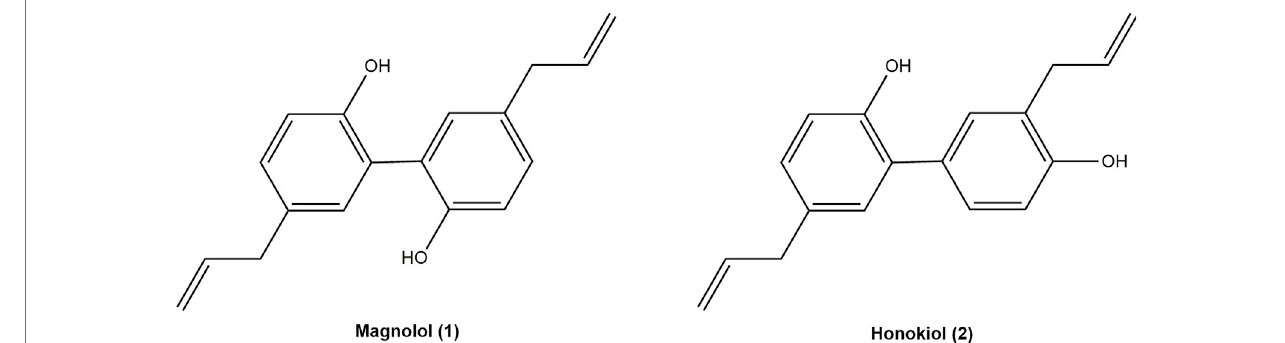
FIGURE 1 | Chemical structures of magnolol and honokiol.